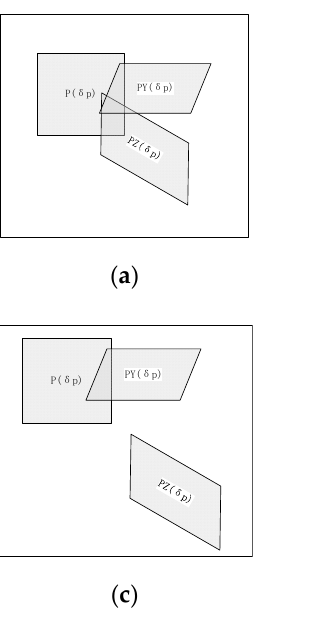
Figure 2. Controllability analysis based on geometric methods: ( a ) The three convex polyhedrons have a nonempty intersection, and the alignment is controllable; ( b ) Only P ( δ P ) and PY ( δ P ) intersect, and the alignment is uncontrollable; ( c ) Only P ( δ P ) and PZ ( δ P ) intersect, and the alignment is not controllable; ( d ) Only PY ( δ P ) and PZ ( δ P ) intersect, and the alignment is